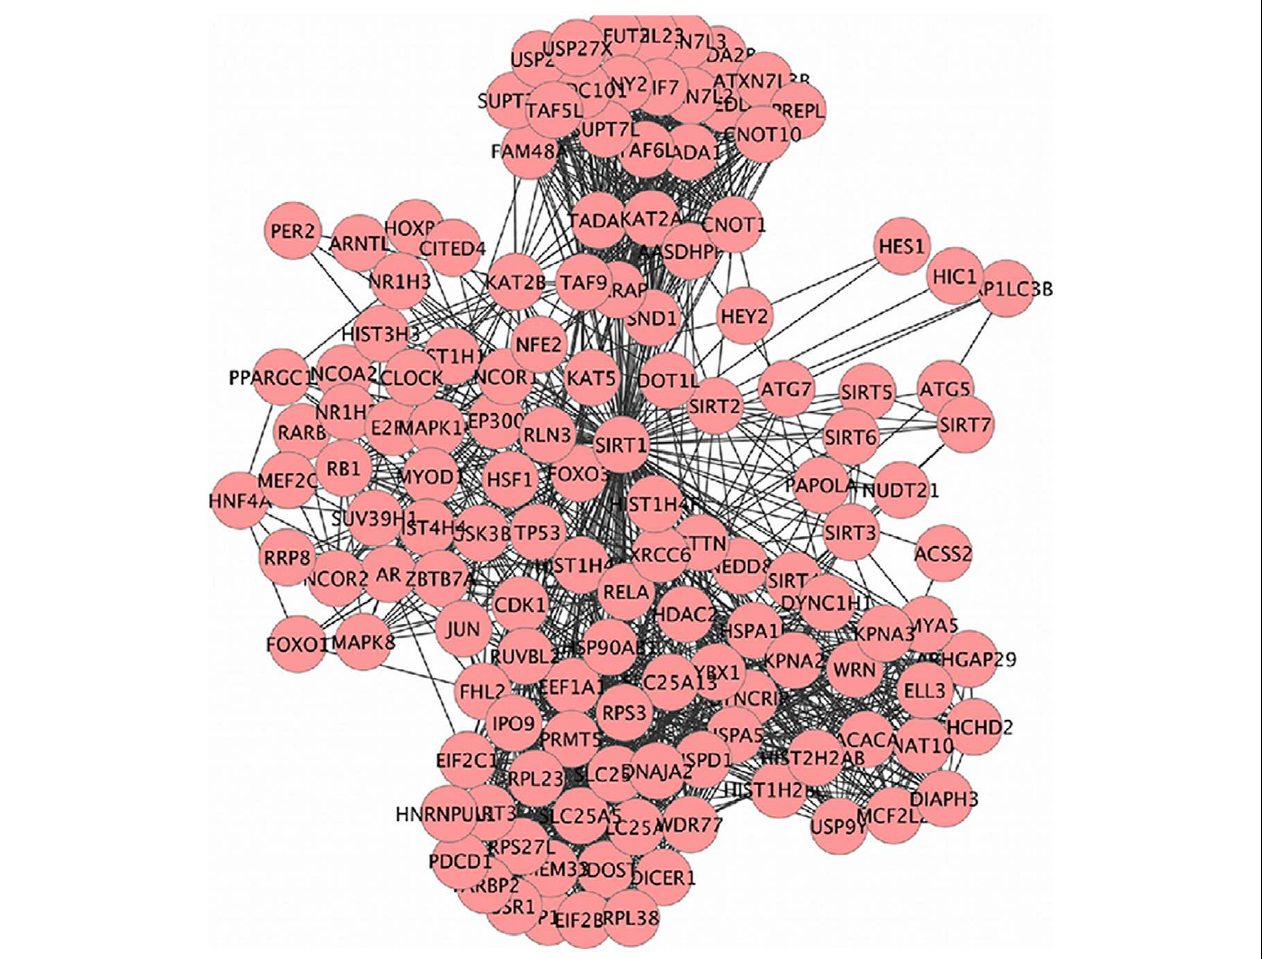
FIGURE 2 | SIRT family interaction maps containing 136 nodes and 1503 edges. Black lines are interactions and nodes (proteins) are represented by